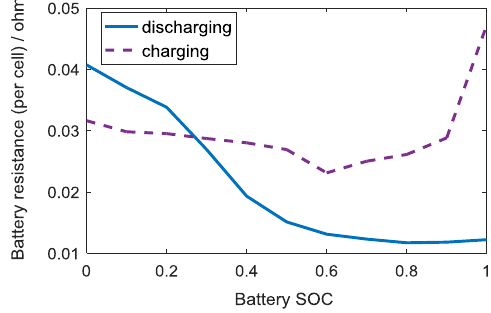
Figure 3. The relationship between the battery internal resistance (per cell) and state of charge(SOC).